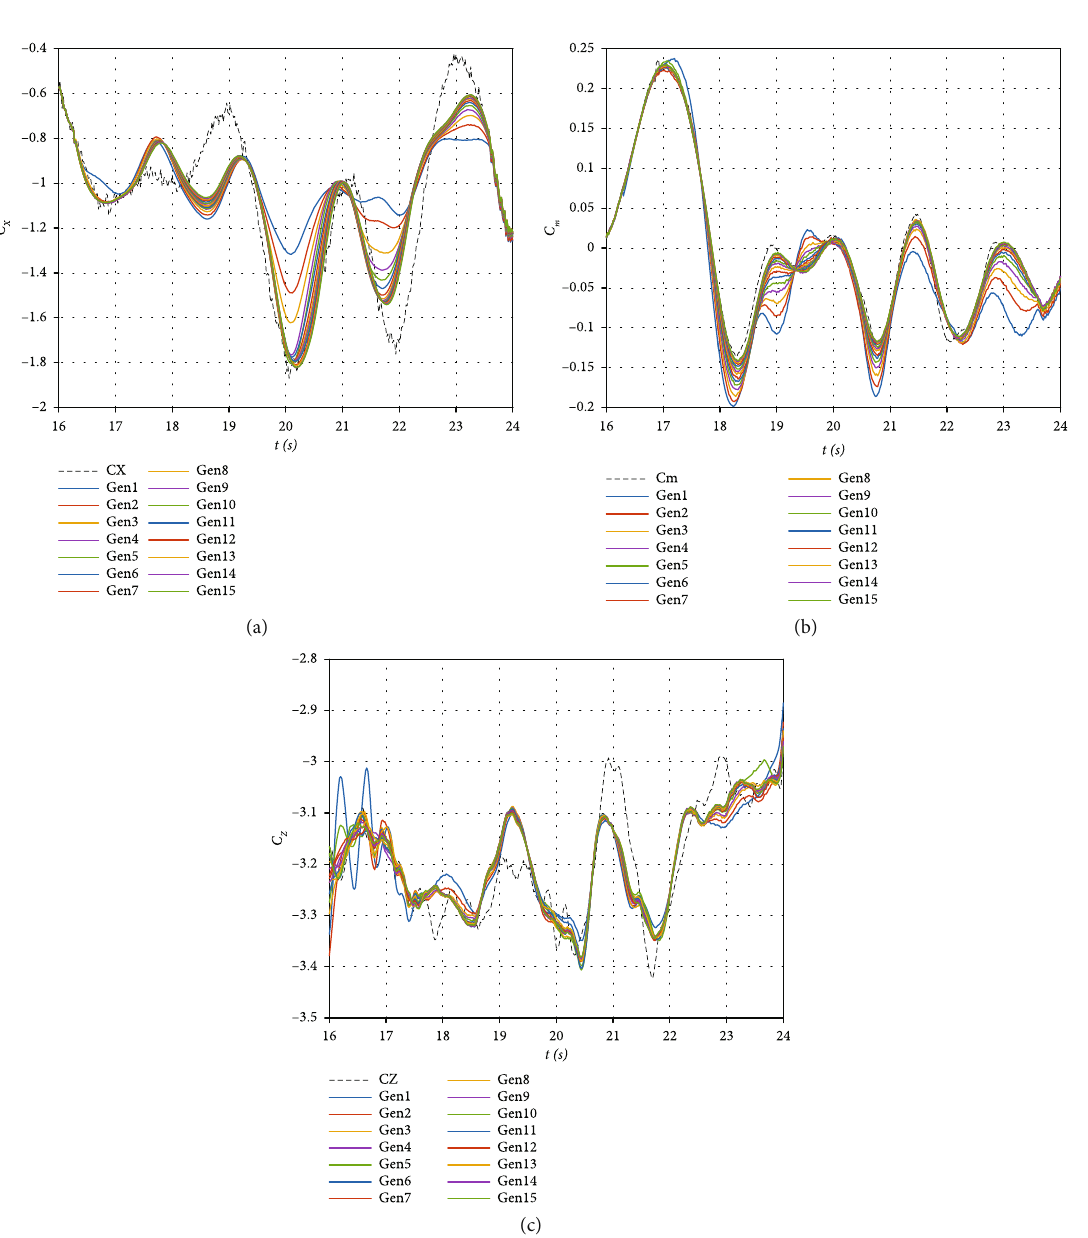
, (b) C , and (c) C X m Z